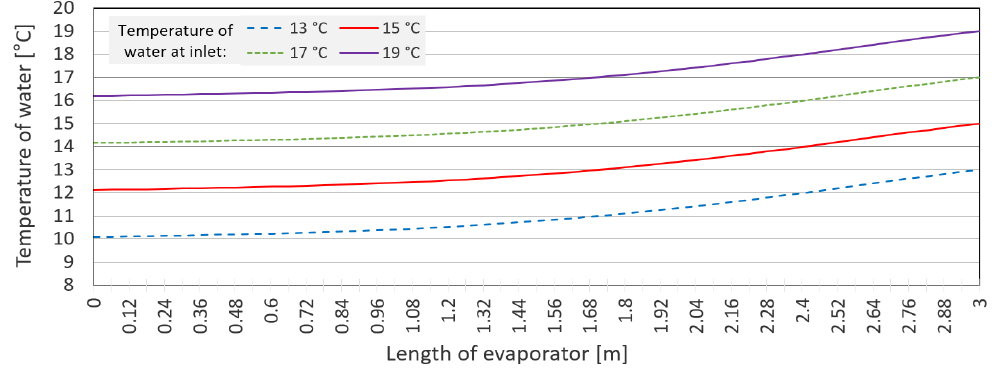
Figure 3. Variation of the temperature of the water.